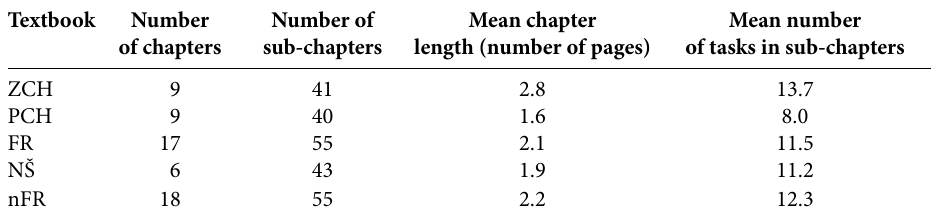
Table 3: Subchapter in textbooks and the tasks they contain Textbook